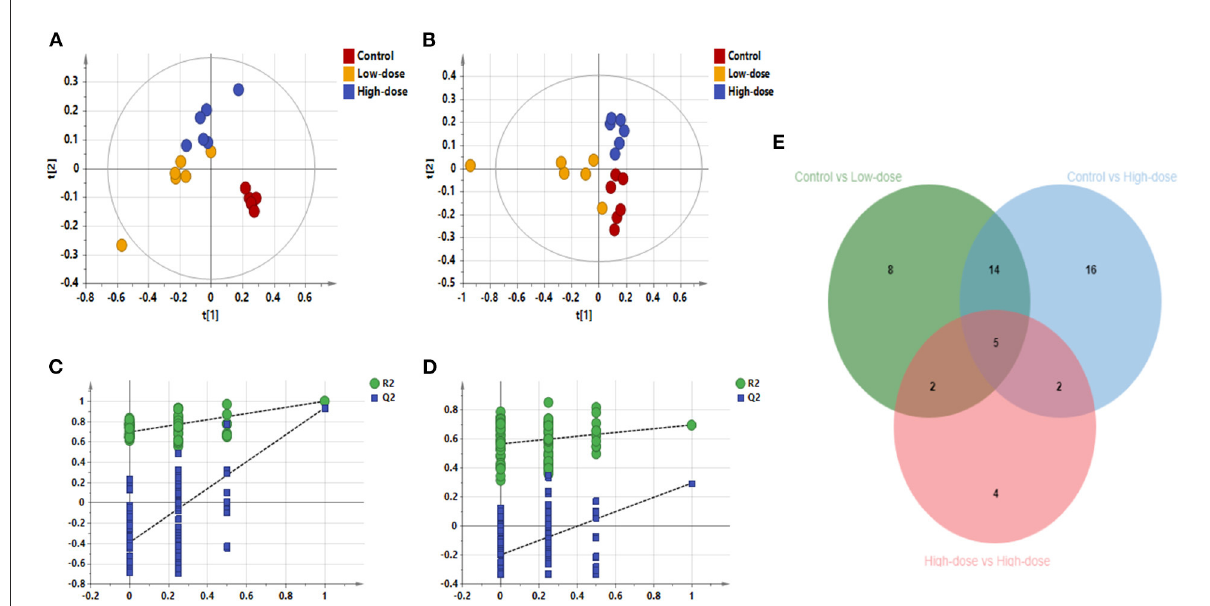
FIGURE5 PLS-DA diagram of all samples. (A) PLS-DA plot in negative ion mode (R 2 X 0.861, R 2 Y 0.996, Q 2 0.938), (B) PLS-DA plot in positive ion mode (R 2 X 0.636, R 2 Y 0.801, Q 2 0.559), (C) Negative ion replacement test, (D) Positive ion replacement test. (E) Venn diagram of the number of differential